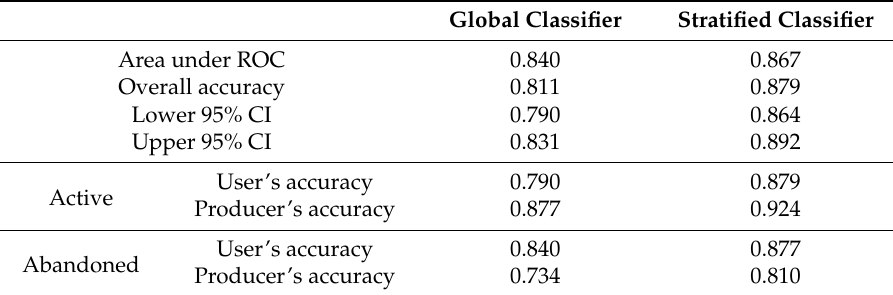
Table 4. Overall, producer’s and user’s accuracies of abandoned and active cropland across 39 administrative level-II regions (provinces) in six countries of the Aral Sea Basin, based on the stratified classifier method.